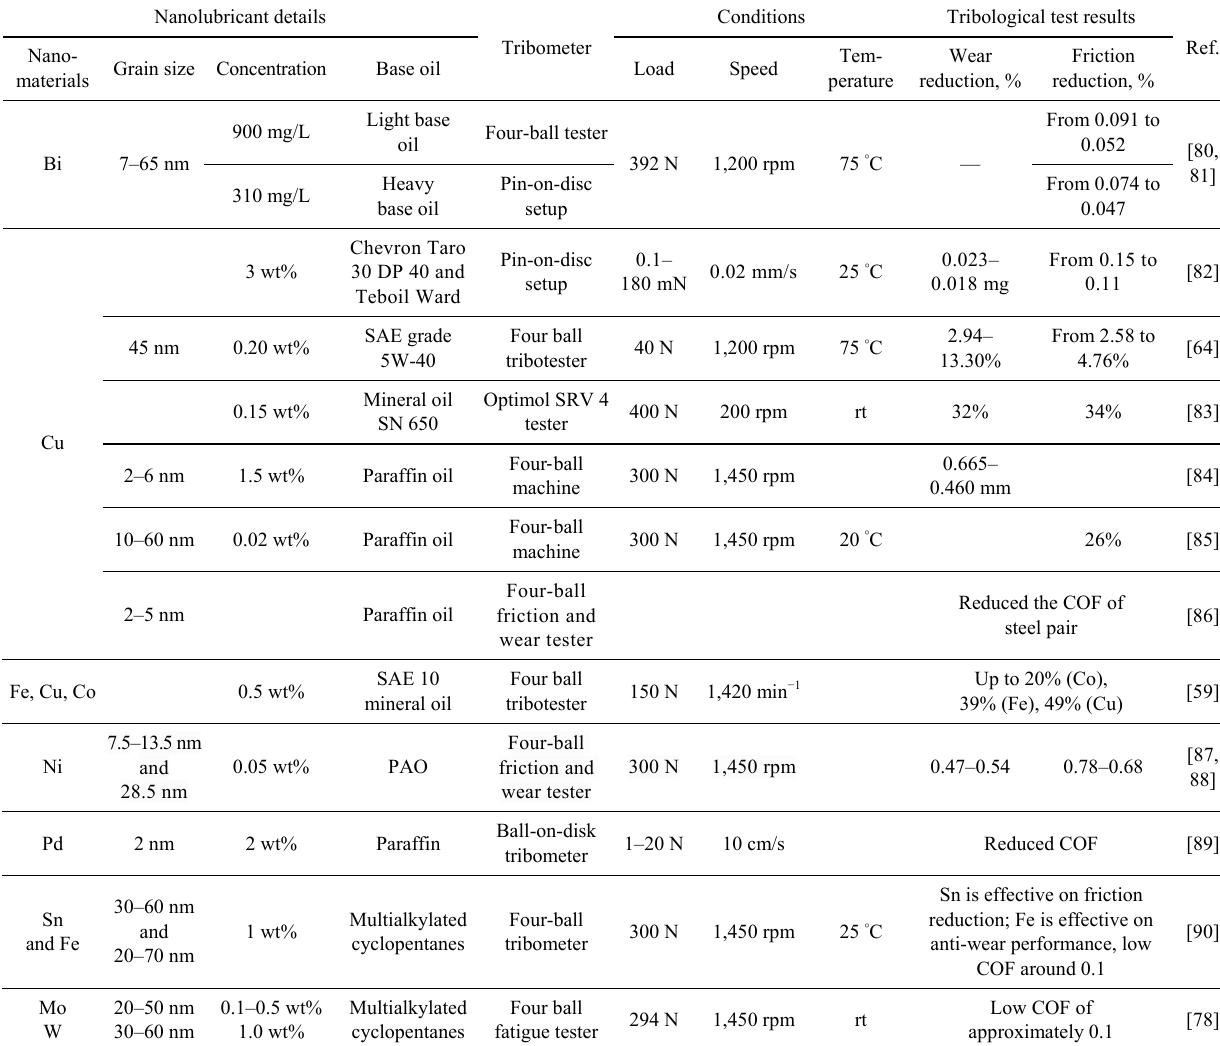
Table 1 Metallic NPs as lubricant